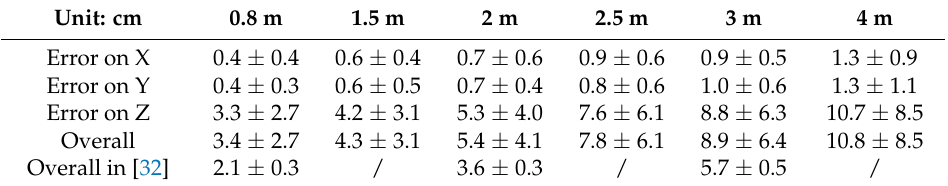
Table 1. Average errors in centimeters at different distances of our method and the comparison with the method in